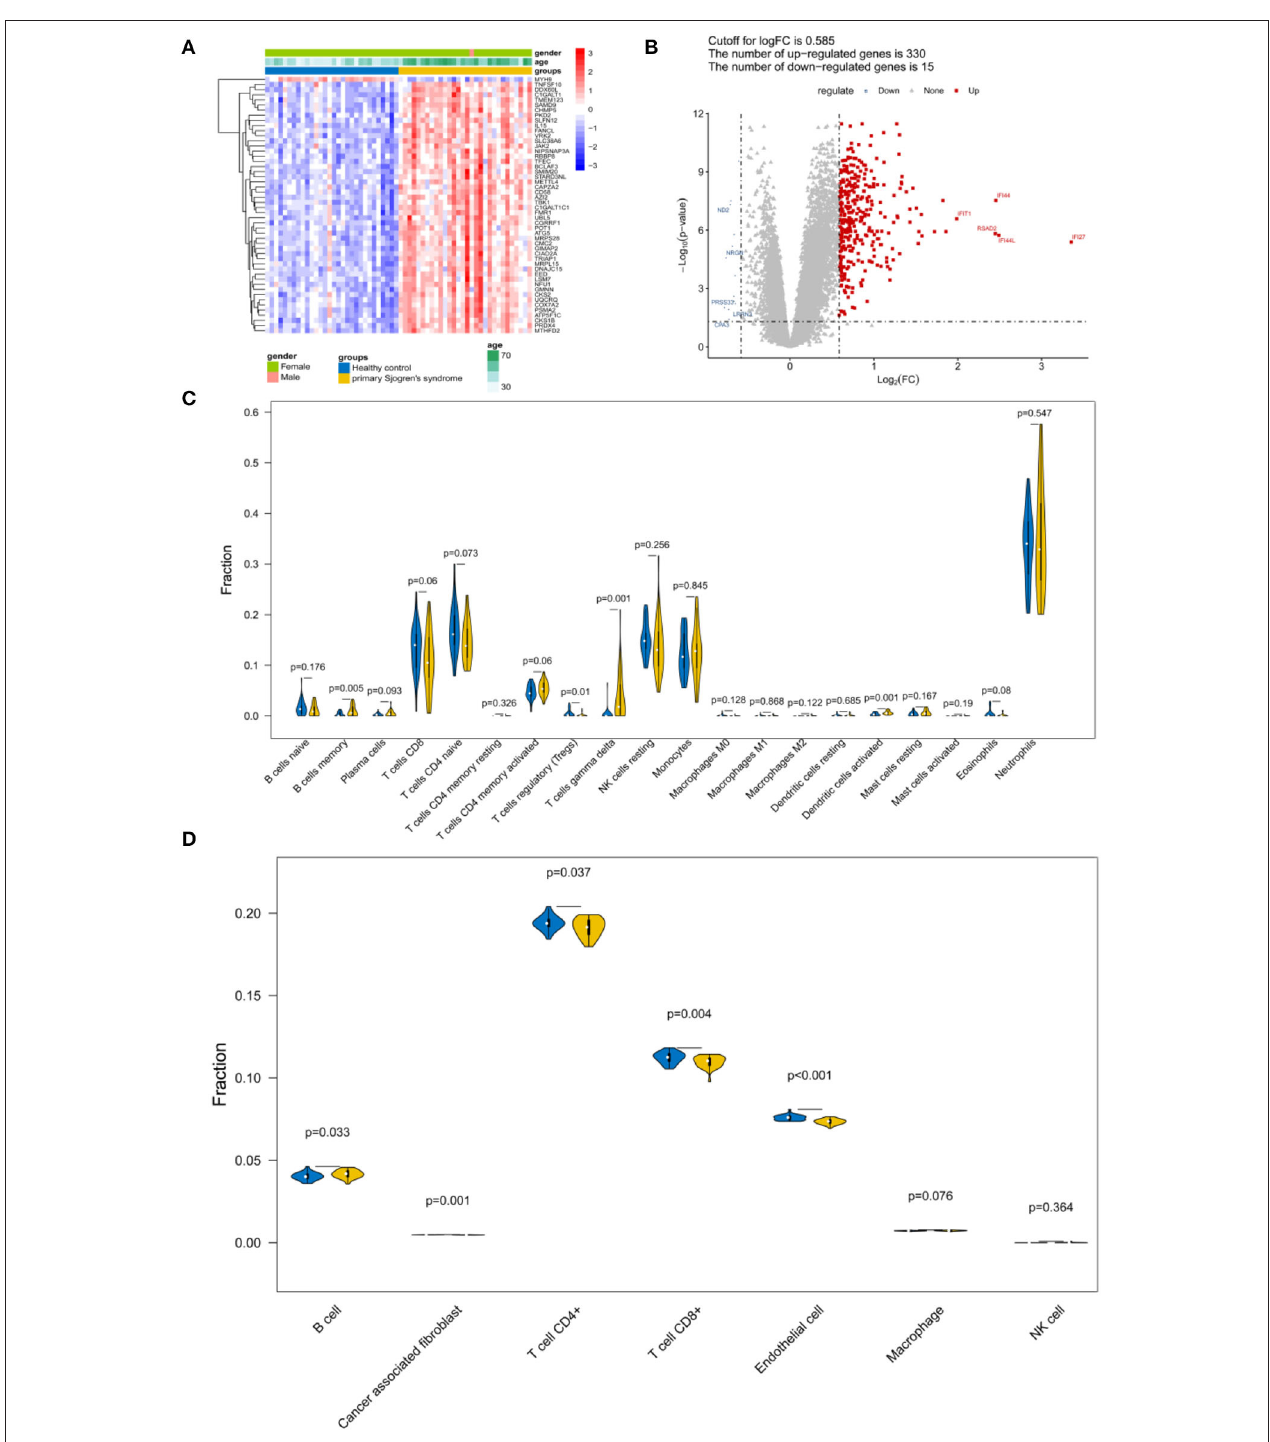
FIGURE 2 | Identification of differentially expressed genes (DEGs) and immune infiltration estimation. (A) Heatmap and (B) volcano plot of the DEGs. (C) Violin plot depicting the abundance distribution of 20 immune infiltrating cell types identified using the CIBERSORT algorithm. (D) Violin plot of the abundance distribution of seven types of immune cells identified using the EPIC tool. The blue strip represents the normal control group and the yellow strip represents the primary Sjögren’s syndrome (pSS) group.